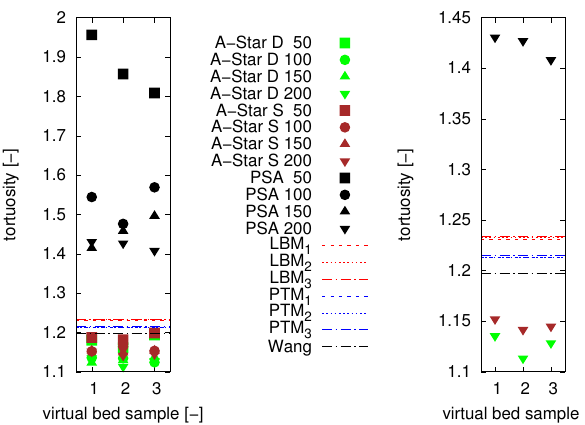
Figure 18. Comparison of tortuosity values (for alternative calculating methods).